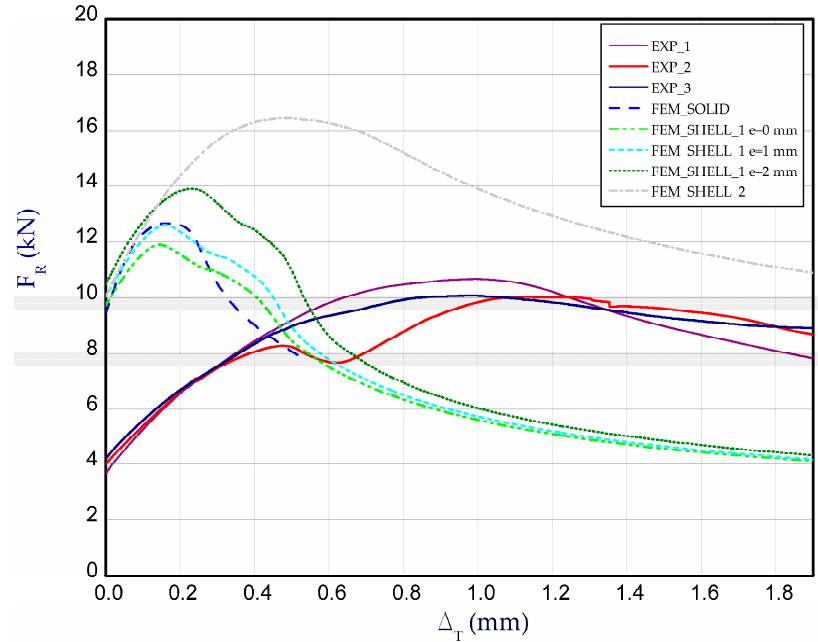
Figure 16. The compression curves of column at 100 °C.